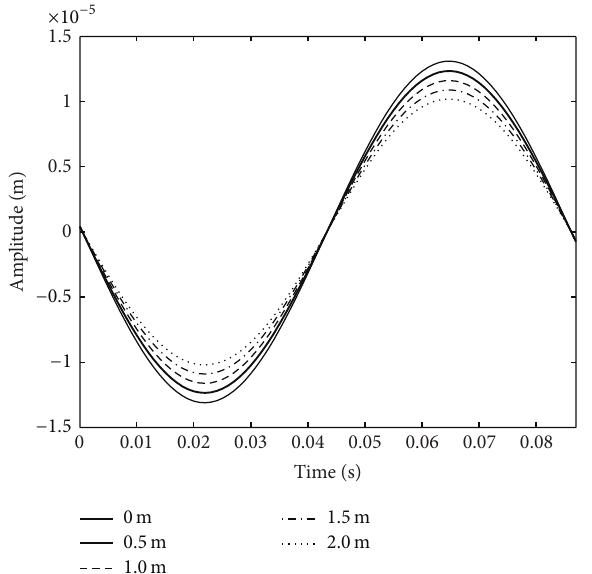
Figure 20: Propeller steady response versus various backward dis- placements of thrust bearing at 100rpm.